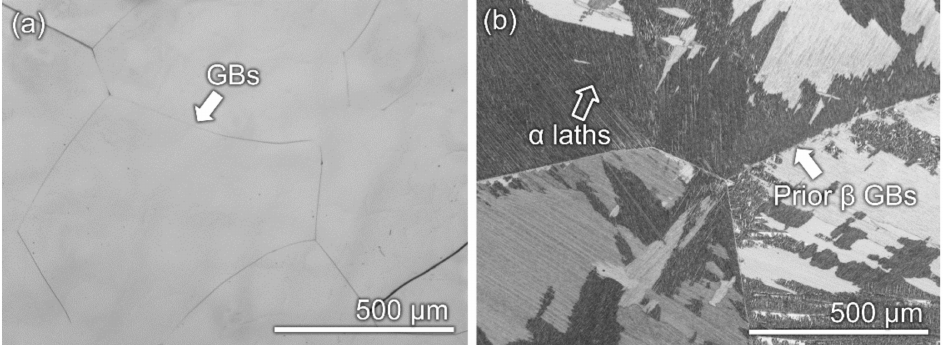
Figure 2. Optical microstructures of ( a ) etched Ti–10Mo–6Zr–4Sn–3Nb and ( b ) Ti–6Al–4V samples. GBs indicates grain